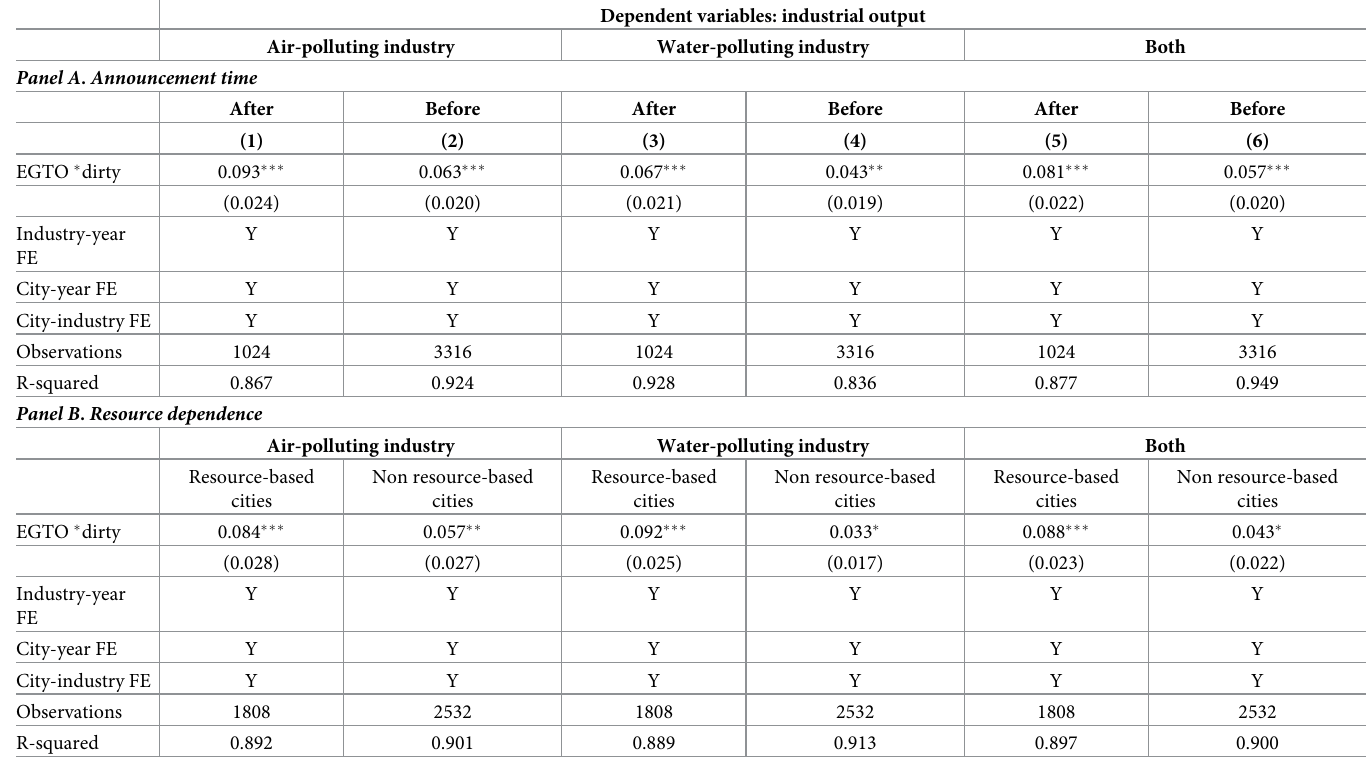
Table 7. Heterogeneous effect of EGTO by target’s announcement time and resource dependence.